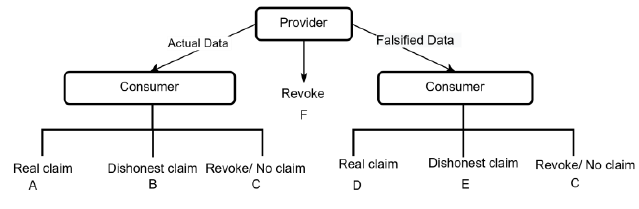
Figure 5: All possible scenarios in trading